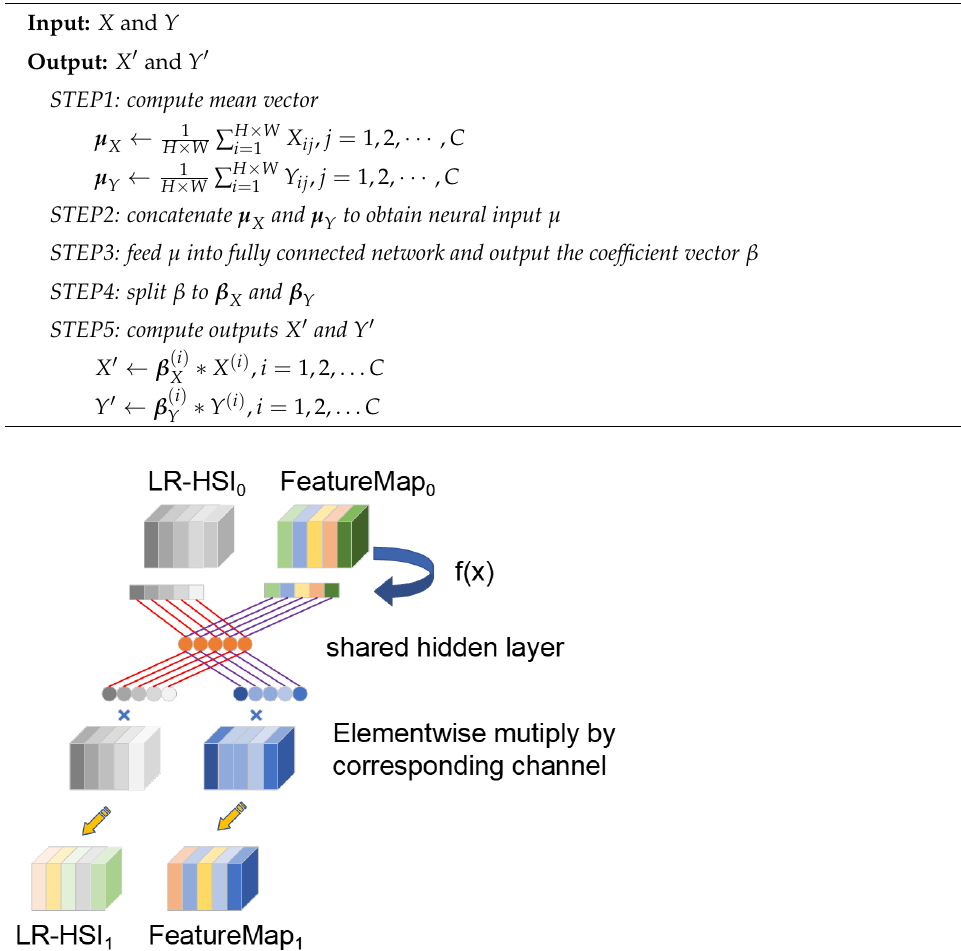
Algorithm 1: Data distribution adjustment in fusion network